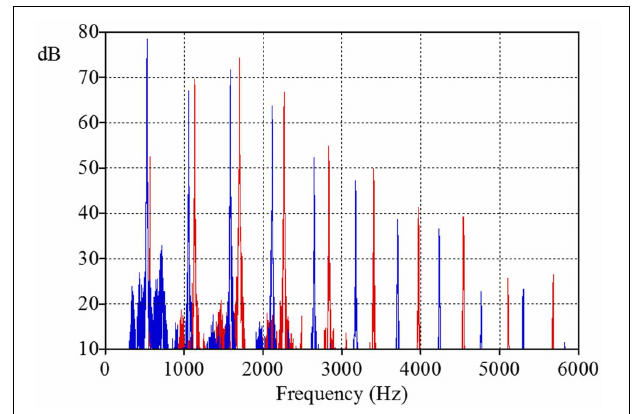
FIGURE 1 | The spectra of stimuli with bright (see red harmonics) and with dull timbre (see blue harmonics) at pitch region around C#5.